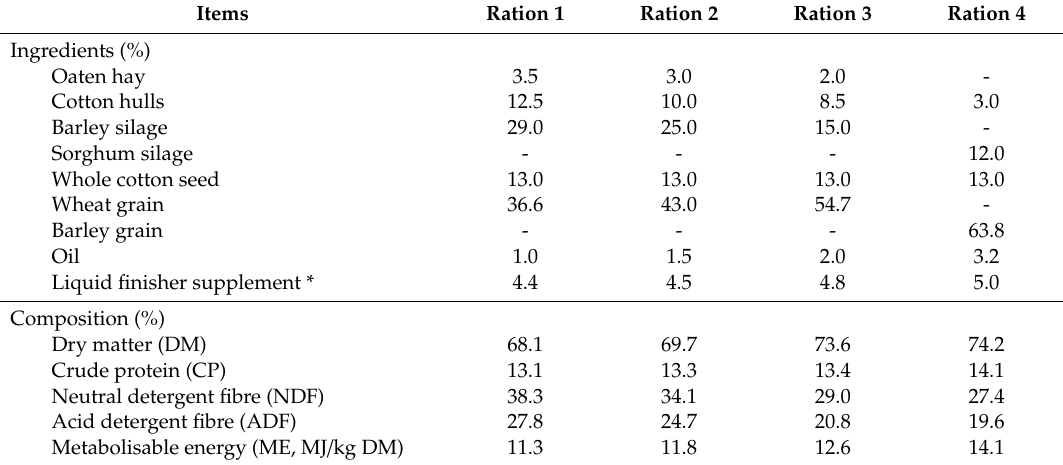
Table 4. Feed composition for the rations o ff ered to cattle in Experiment